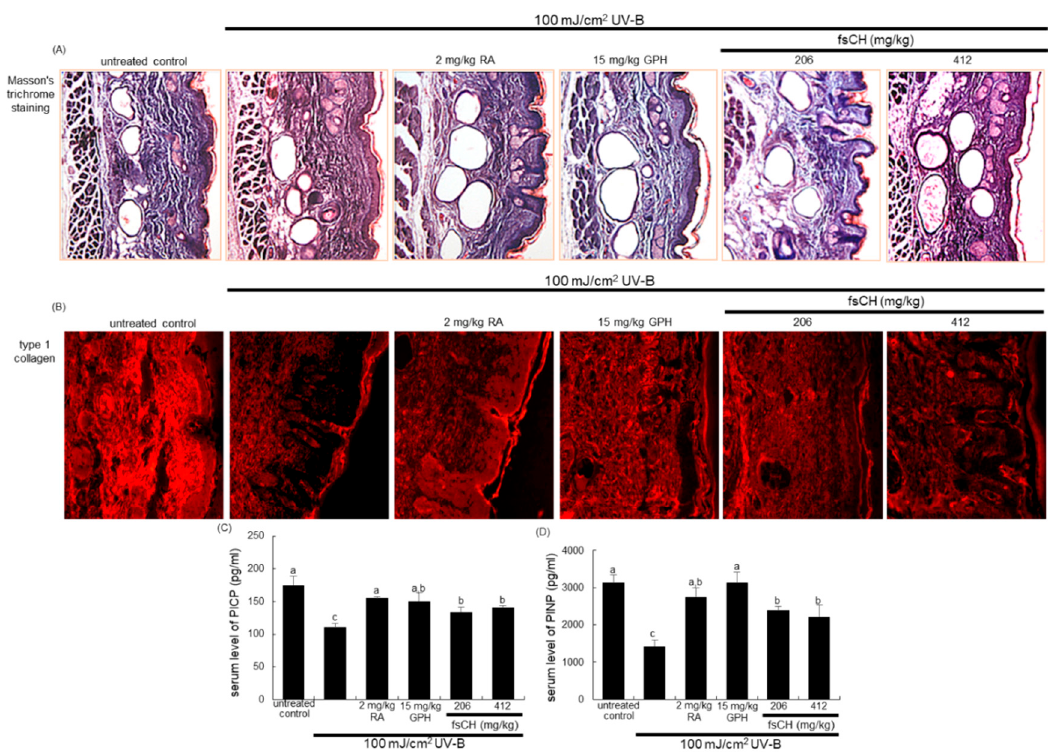
Figure 6. Effects of oral administration of Pangasius hypophthalmus fish skin hydrolysates (fsCH) on ultraviolet-B (UV-B)- induced collagen loss of hairless mouse dorsal skin. SKH-1 hairless mice were exposed to UV-B radiation three times a week and treated with 2 mg/kg retinoic acid (RA) intraperitoneally and with 15 mg/kg glycine-proline-hydroxyproline tripeptide (GPH) and 206–412 mg/kg fsCH orally for eight weeks. Masson’s trichrome staining was performed with mouse dermal skin for collagen fibers stained in blue ( A ). For the measurement of dorsal skin tissue level of type 1 collagen in UV-B-irradiated SKH-1 hairless mice, immunohistochemical staining was conducted with an antibody against type 1 collagen ( B ). Each photograph is representative of four animals. Serum levels of procollagen type 1 carboxy-terminal propeptide (PICP) and procollagen type 1 amino-terminal propeptide (PINP) were measured by using ELISA kits ( C , D ). Values in bar graphs (mean ± SEM, n = 3) not sharing a small letter are different at p < 0.05.